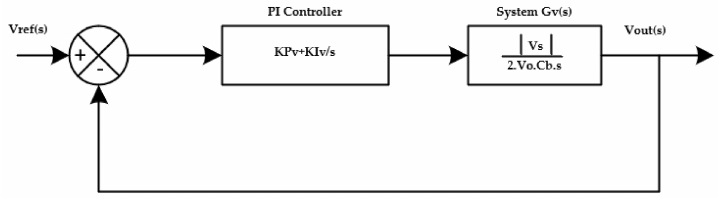
Figure 7. Block diagram of the outer voltage control loop using the PI